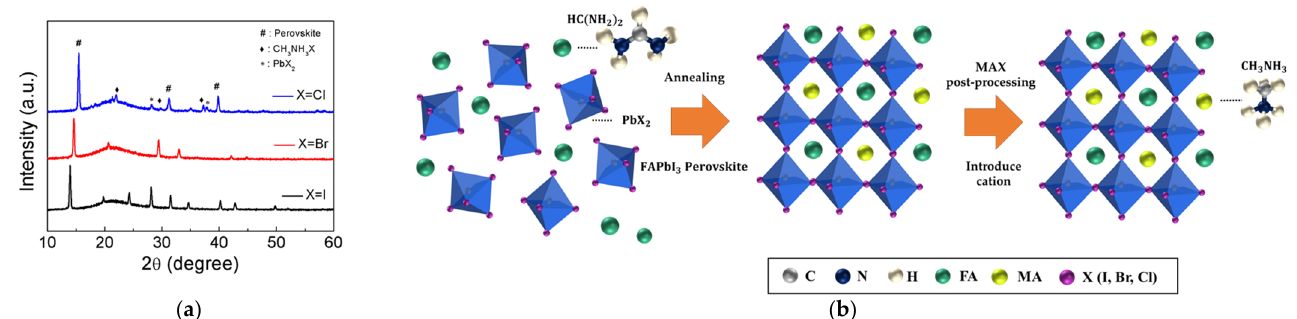
Figure 2. ( a ) XRD pattern of the FAPbX 3 ‐ MAPbX 3 (X = I, Br, and Cl) films, ( b ) Schematic of mixed cation halide perovskite for incorporation of cations.